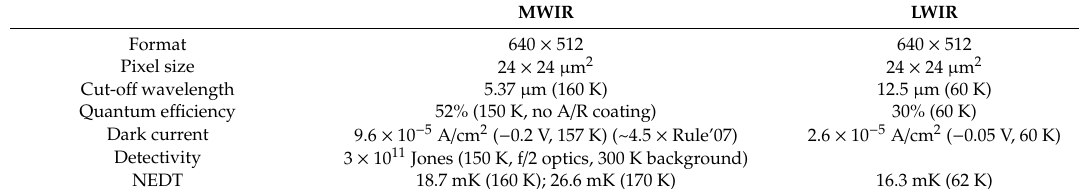
Table 7. Performance of InAs/InAsSb T2SLs nBn detector FPAs ([172,211]).